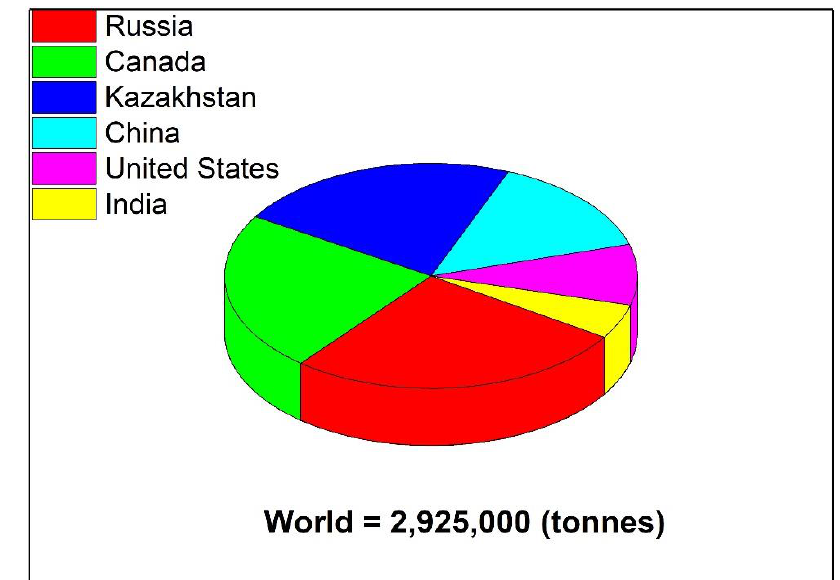
Figure 2. Some major flax producing countries of the world.